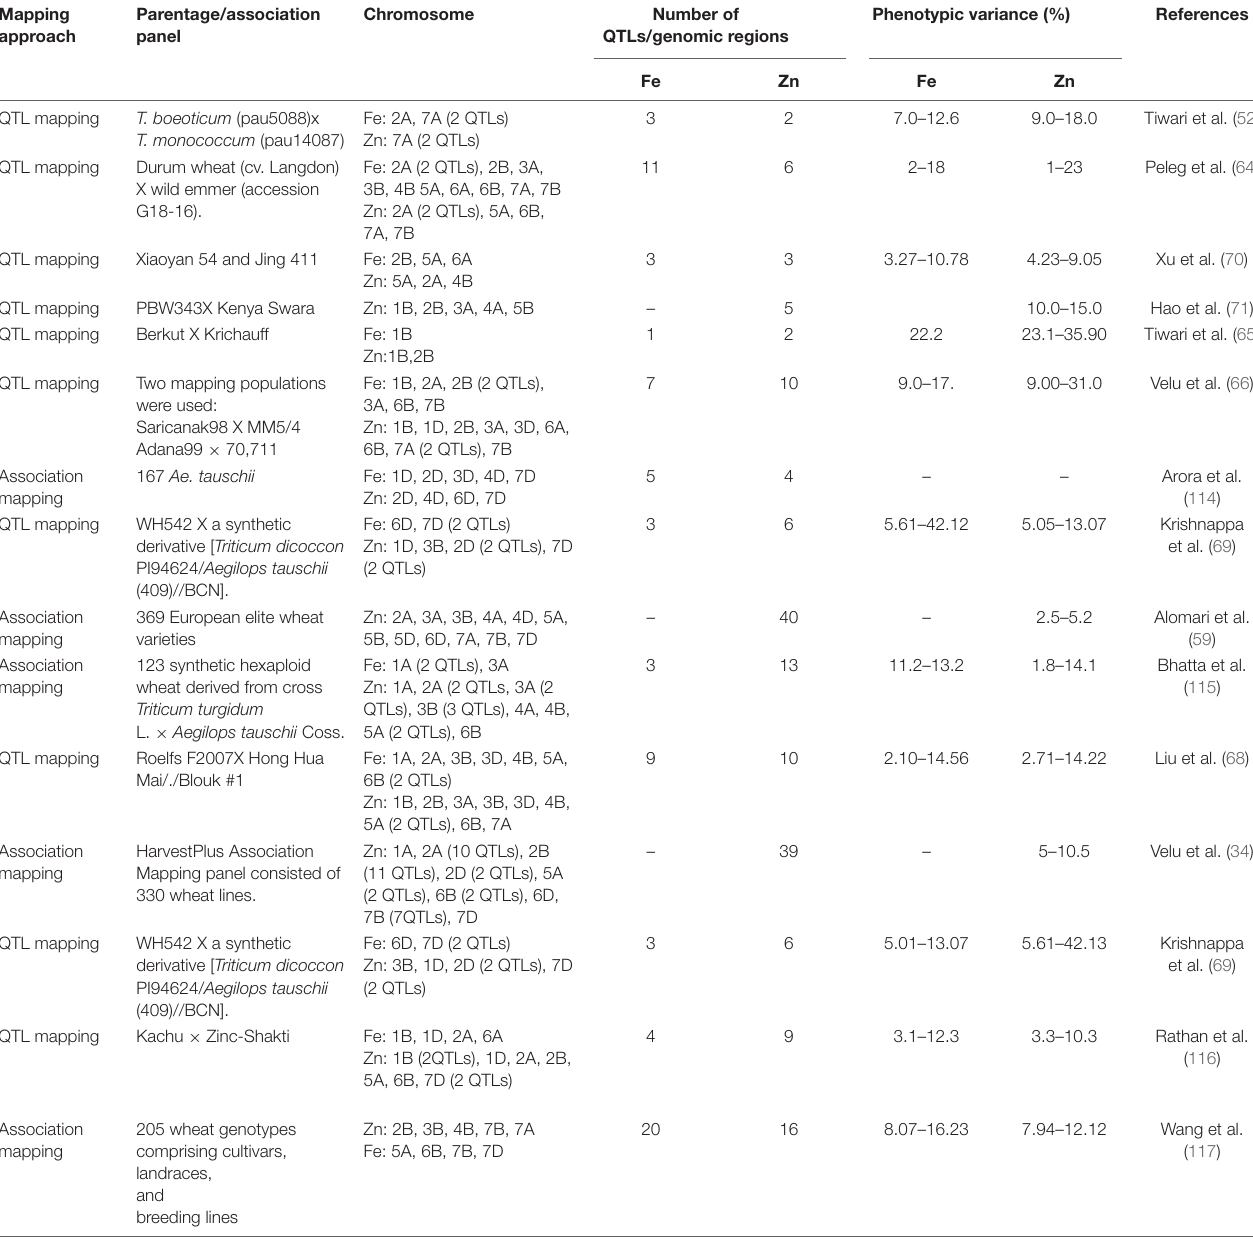
TABLE 1 | Genomic regions/QTLs identified for grain Zn and Fe concentrations in cultivated and wild wheat using biparental and association analysis